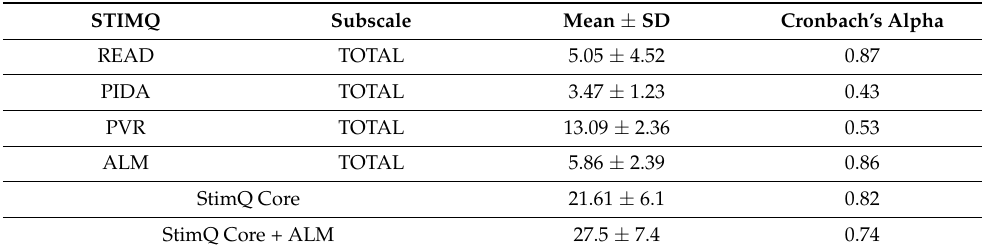
Table 2. Cronbach’s alpha of subscale and total scores for infants.